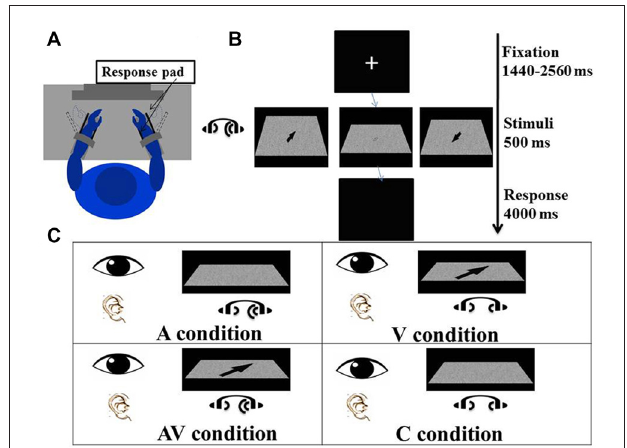
FIGURE 1 | Experimental procedure and conditions. (A) The participant sat comfortably in front of a screen with both forearms on the response device on the desk, which had been adjusted to elbow height. Both hands were placed between the two plastic keys (response pads) that were used to give responses. The distance between the eyes and the screen was adjusted to 80 cm. (B) The experiment procedure: a fixation cross was first presented at the center of the screen for a random duration between 1440 ms and 2560 ms. Visual and/or auditory stimuli were presented for 500 ms after the fixation. The arrow displayed on the left screen is enlarged to illustrate the direction of a “right far” stimulus; the arrow displayed on the right screen is enlarged to show a “left near” stimulus; and the arrow displayed on the middle screen is a blurred “right far” stimulus as actually seen by the participant. A blank screen was then shown for 4000 ms and participants were asked to indicate the direction of visual and/or auditory stimuli. (C) There were four conditions of the experiment in which visual and auditory stimuli were presented simultaneously. In the auditory (A) condition, lateralized “Bat-ears” sound and visual noise were presented. In the visual (V) condition, visual noise with an arrow pointing to one of the four directions and non-lateralized “Bat-ears” sound were presented simultaneously. The audiovisual (AV) condition was composed of visual noise with an arrow and lateralized “Bat-ears” sound. The neutral (C) condition involved visual noise and non-lateralized “Bat-ears” sound.